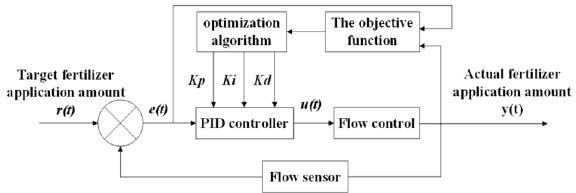
Figure 1. Schematic diagram of the process of optimizing PID